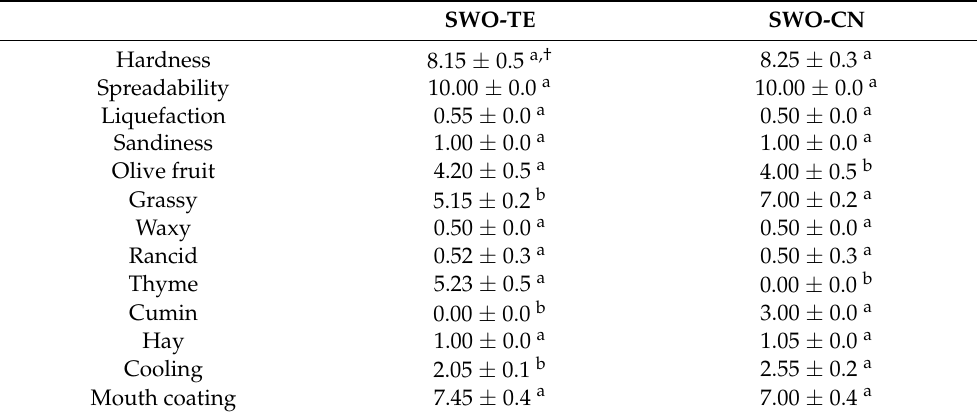
Table 4. The sensory quantitative descriptive analysis (QDA) results of the prepared thyme and cumin-flavored virgin olive oil-sunflower wax